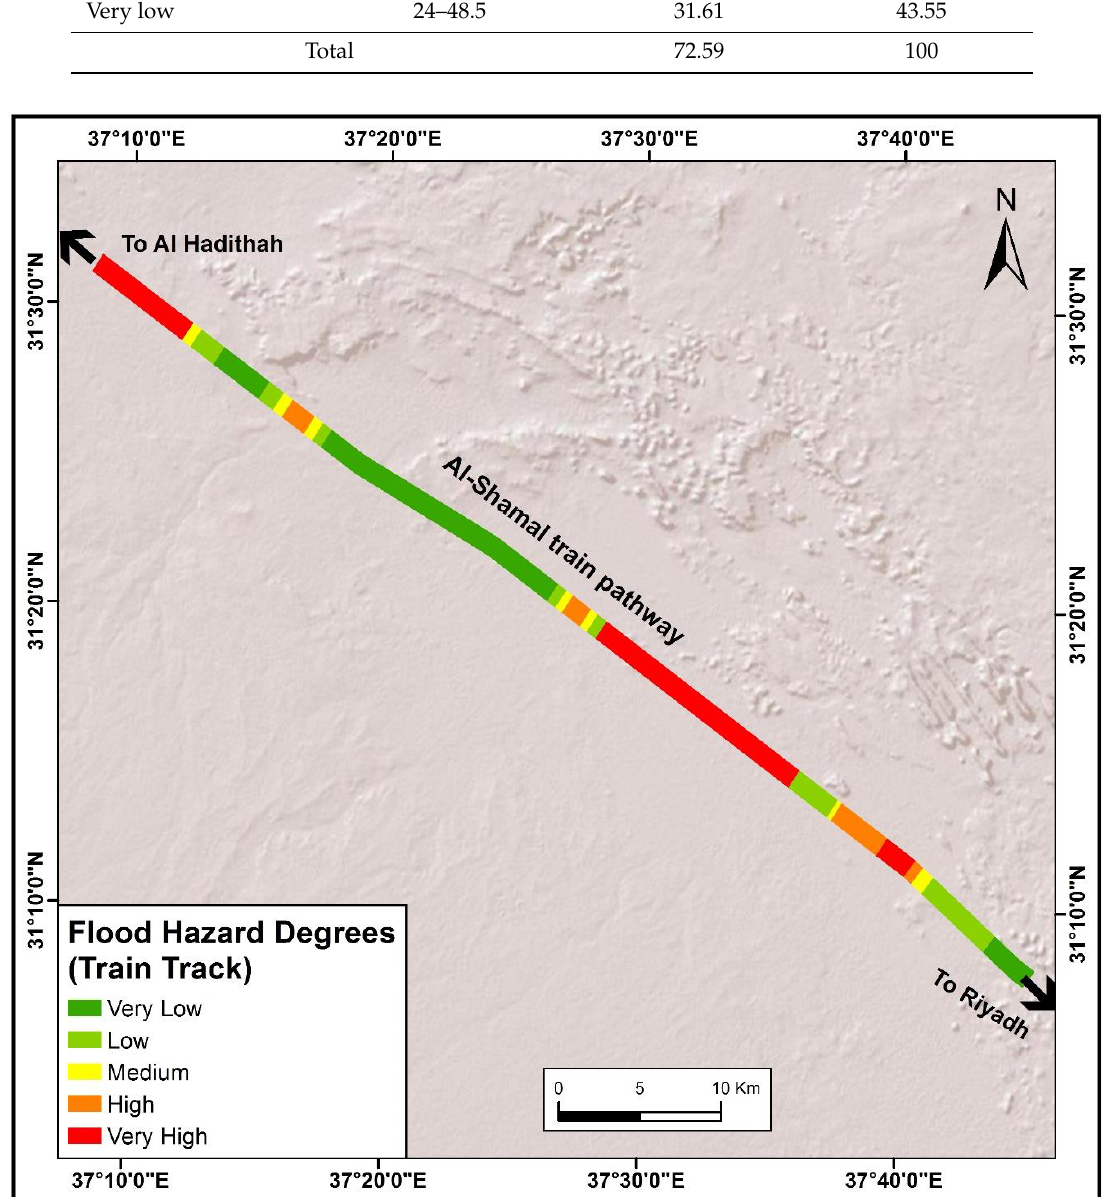
Figure 15. Degrees of flood hazard on the Al-Shamal train pathway in the study area in 2020.